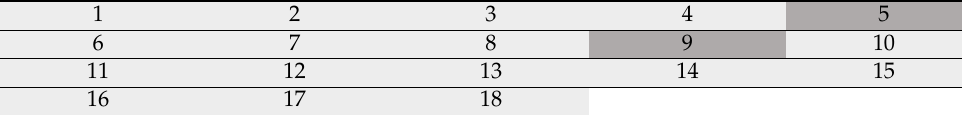
Figure 8. Dimensions of quality requirements in KGs [62]. Table 3. Evaluation results of the